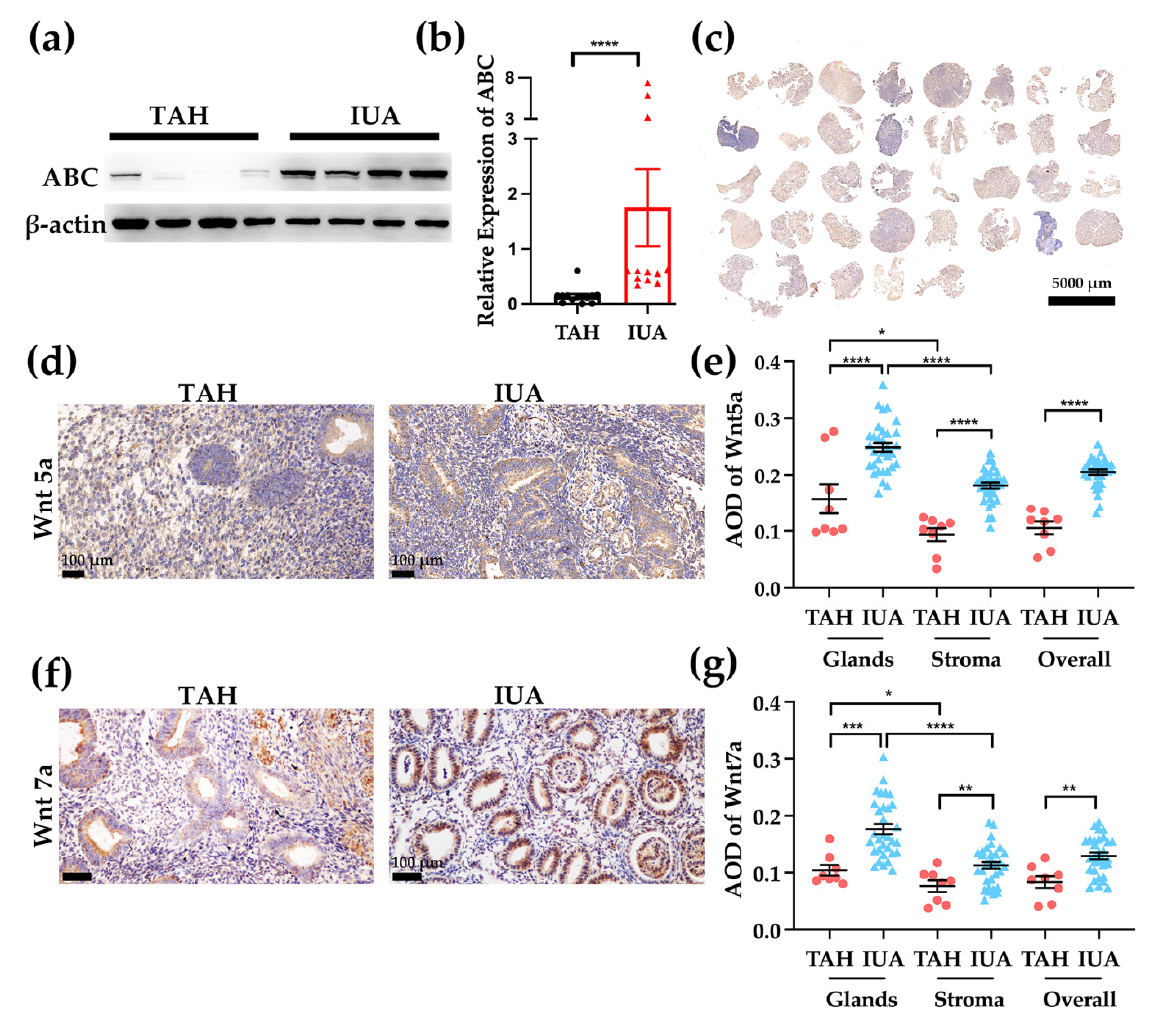
Figure 2. ( a ) The tissue array of endometria with IUA from 37 patients was established. Scale bar, 5 mm. ( b ) Western blot analysis was performed to examine the expression level of non-phosphorylated β -catenin (ABC, active β -catenin) in endometria of TAH and IUA patients. ( c ) Relative quantification of ABC normalized to β -actin (TAH n = 13; IUA n = 12). ( d ) Endometrial sections were stained with anti-Wnt5a using IHC. ( e ) Average optical density (AOD) of Wnt5a stained by IHC is presented in dots (TAH n = 8; IUA n = 32). Scale bar, 100 µ m. ( f ) Endometrial sections were stained with anti-Wnt7a using IHC. Scale bar, 100 µ m. ( g ) AOD of Wnt7a stained by IHC is presented in dots (TAH n = 8; IUA n = 32). Data are presented as mean ± SEM. * p < 0.05, ** p < 0.01, *** p < 0.001, **** p < 0.0001.